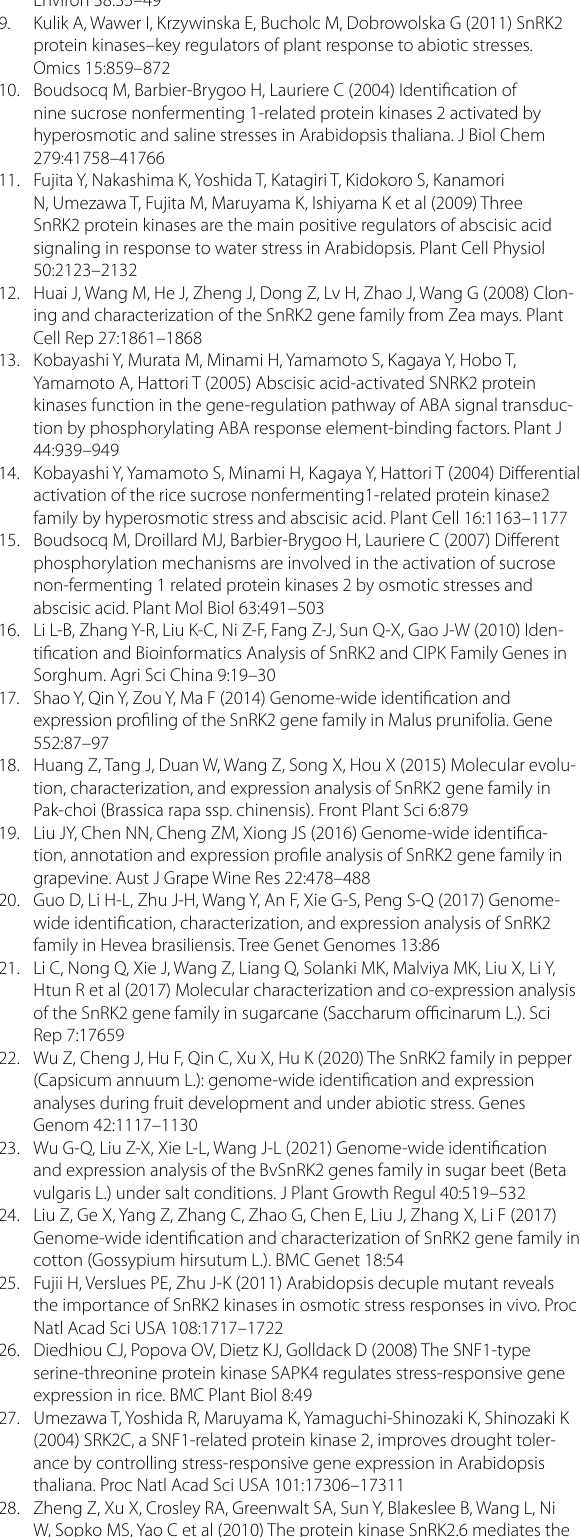
Ontology (GO) annotation details for Co and CcSnRK2 proteins in both Corchorus species. Table S6. Promoter analysis of SnRK2s genes of two jute species using PlantCare database. Table S7. Promoter analysis of SnRK2s genes of two jutre species using PLACE database. Table S8. Differ- entially expressed SnRK2 genes in in different plant parts (a), and against waterlogging (b), Salinity (c) & Drought (d) condition. Table S9. Genome- wide identification and classification of SnRK2 genes in 21 plant